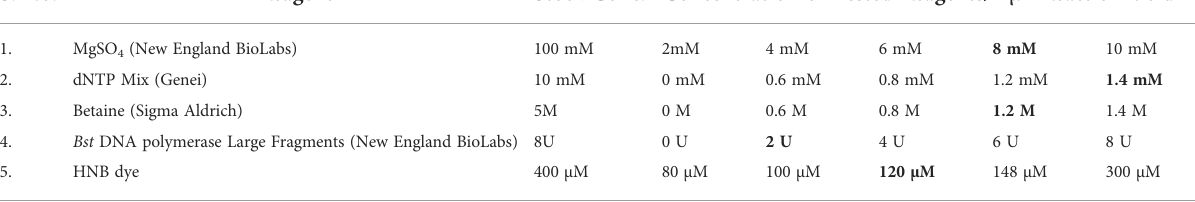
TABLE 2 Standardization of reagents used in LAMP assay.